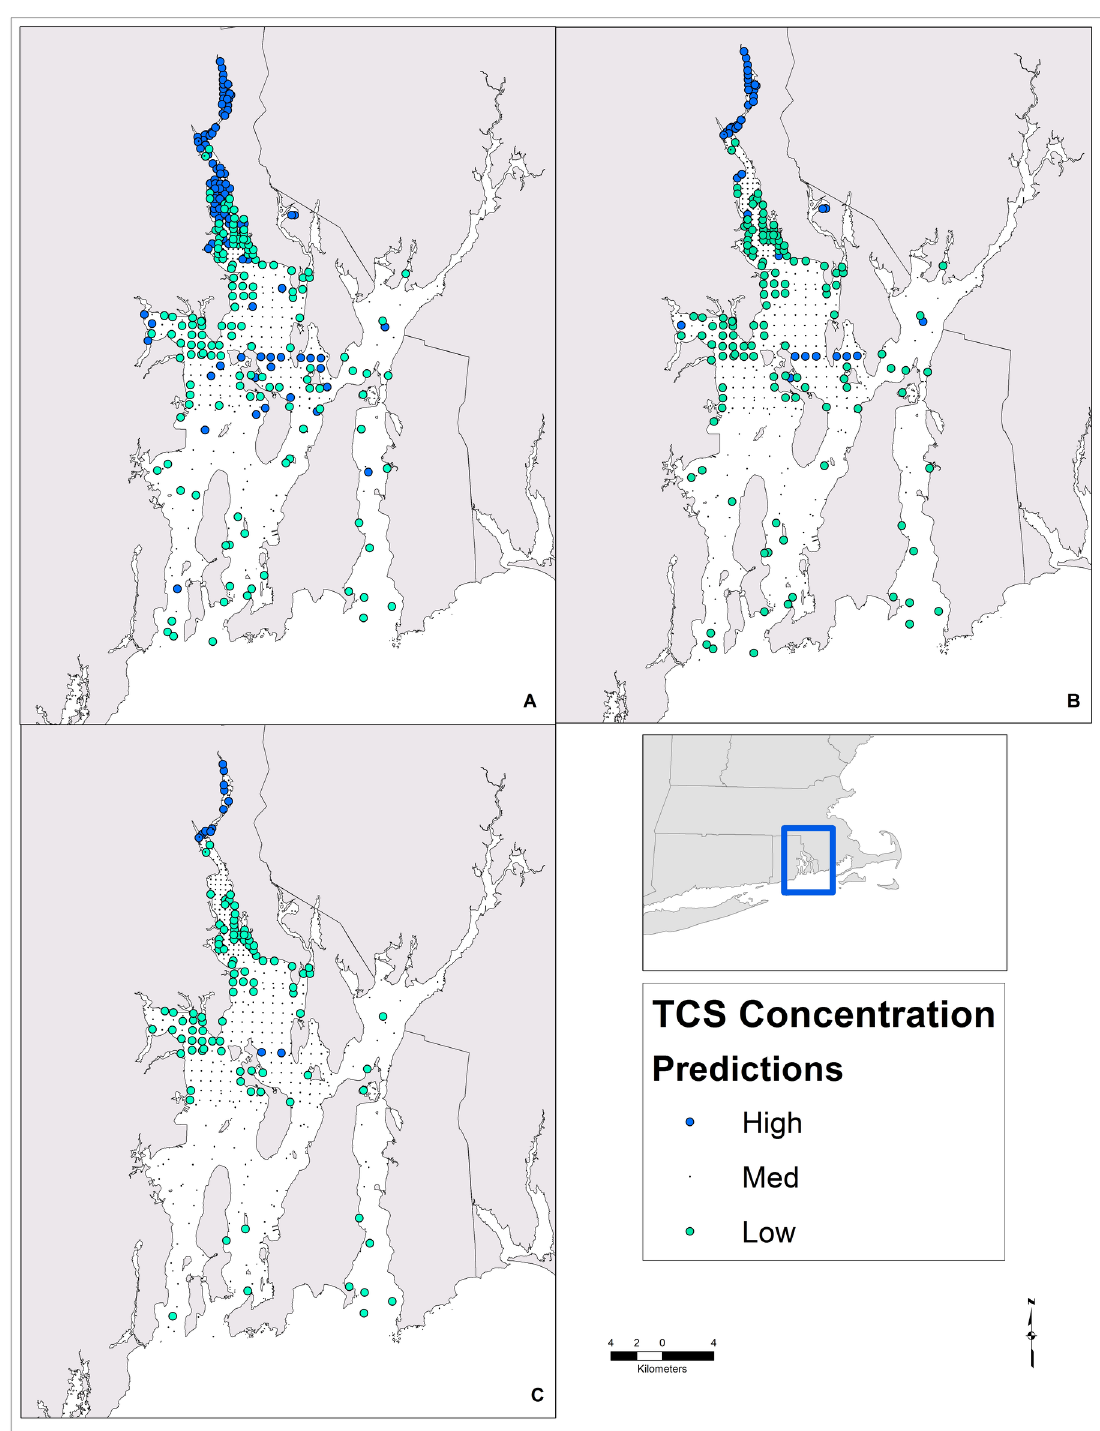
Fig 3. The predicted distribution of triclosan contamination based on three different quantile discretizations of a Random Forest regression model predictions. Maps A, B, and C represent the respectivemodels (A, B, C). The medium contamination class points have been minimizedto improvevisualizationof the low and high contamination classes.